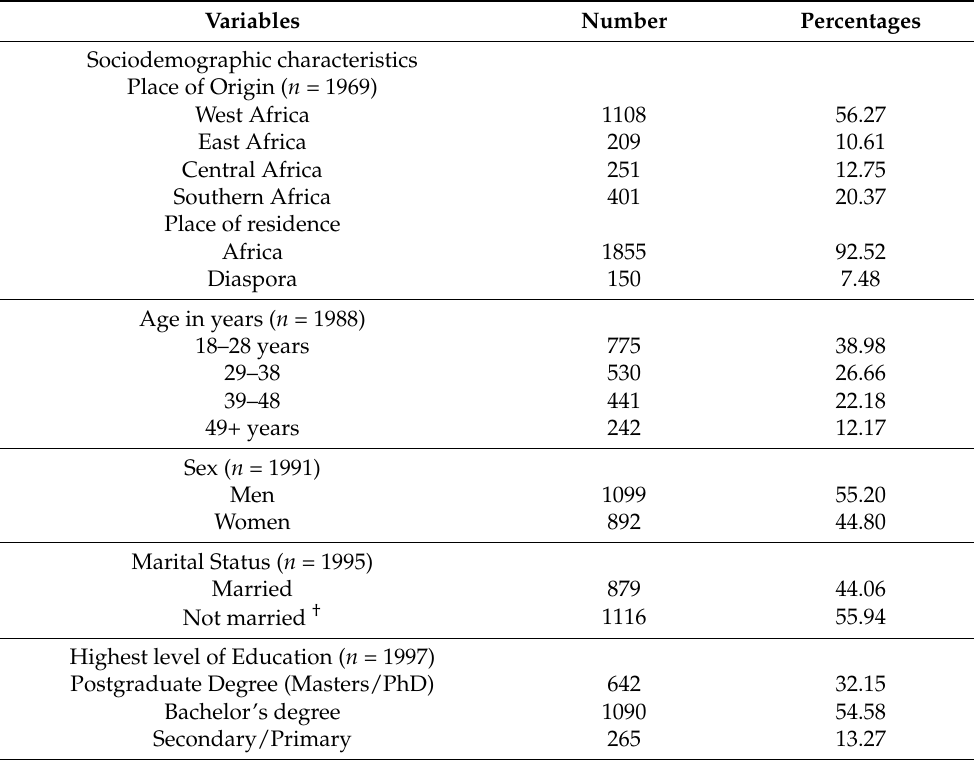
Table 1. Characteristics of the study population ( N =